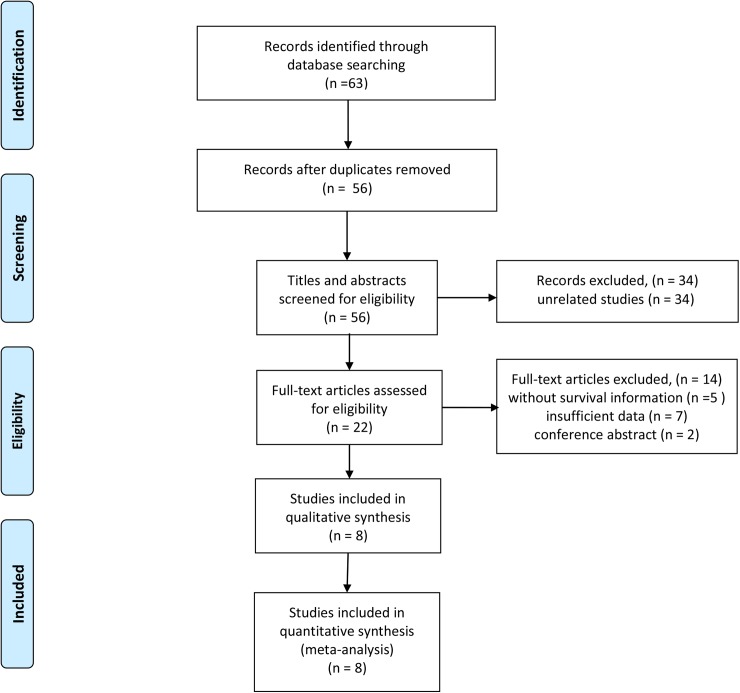
Flow diagram of the study selection process.